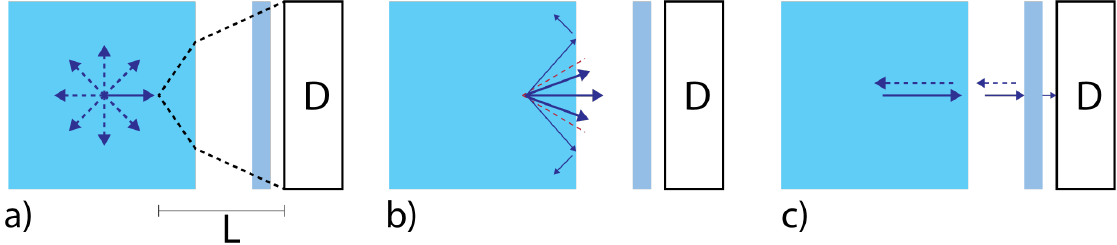
Figure 1. Main sources of light losses at the scintillator ( light blue )-photodetector (D) interface: ( a ) Light collection efficiency ( ∝ L 2 , with L being the distance between the light source and the photodector); ( b ) total internal reflection ( TIR angle = sin ( n crystal / n air )); and ( c ) Fresnel losses ( ∝ ∆ ( n ) 2